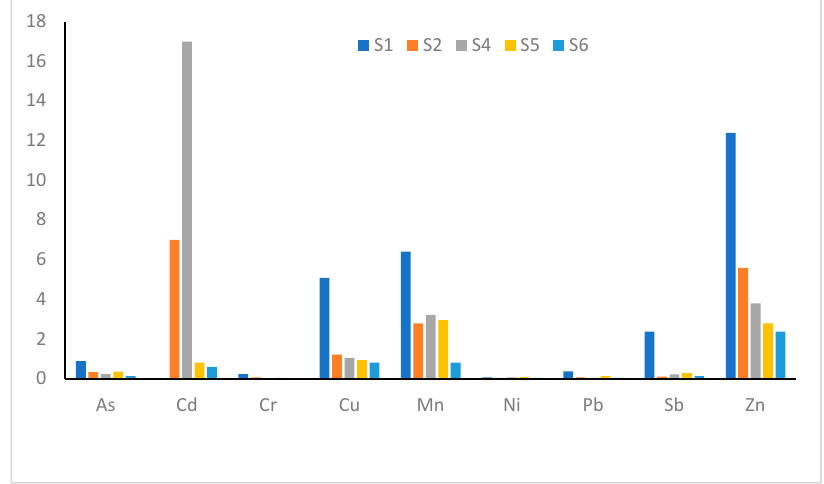
Figure 2. Composition of chemical elements in the sediments and the tissue of Gomphidae larvae.